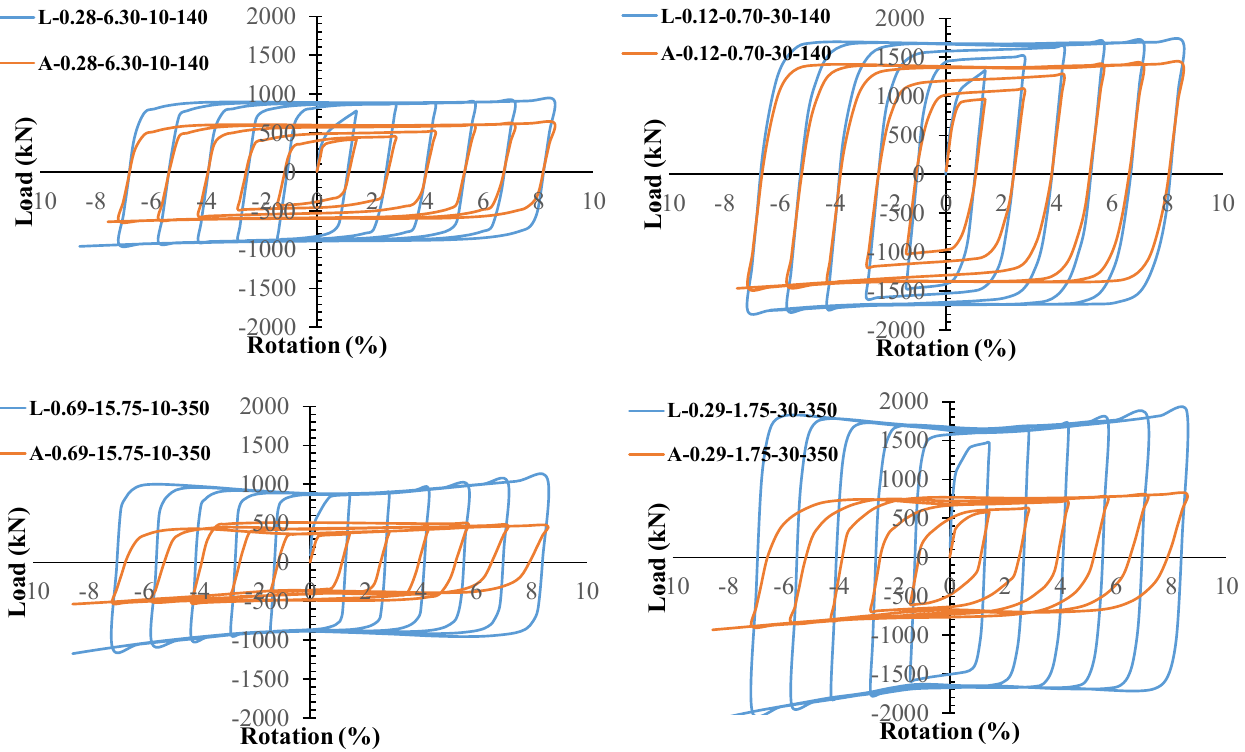
Figure 4. Comparing the hysteresis curve of the LYP and A36 dampers. Comparing the hysteresis curves of the dampers shown in Figure 5 confirms that ρ and ψ affected the hysteresis curves. By reducing h and increasing the t f , the hysteresis loop shows a better performance. As shown in this figure, by reducing ρ , the ultimate strength and stiffness of both LYP and A36 dampers are increased but the rate is different. The parameters are considered exactly in the next sections.